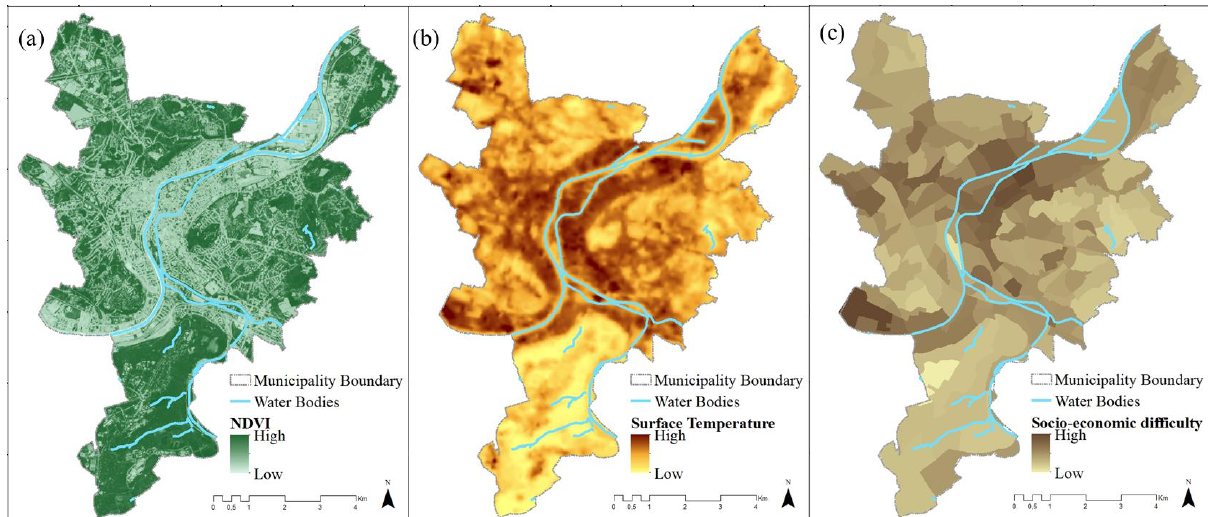
Figure 4. Spatial distribution of (a) NDVI, (b) Surface temperature (c) Socio-economic deprivation index in Liege